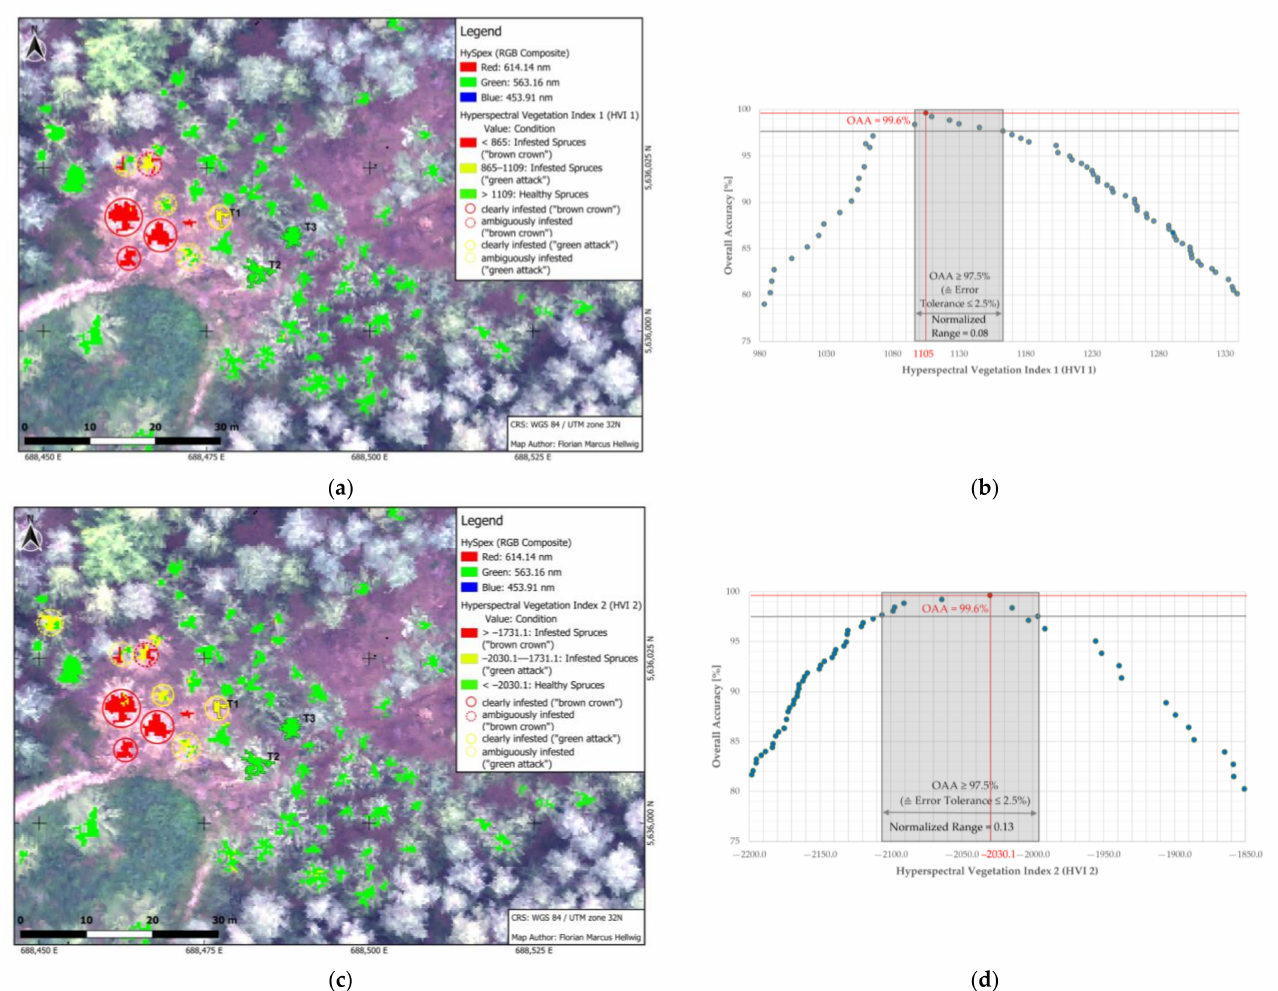
Figure 13. State of the spruces in the first study area using hyperspectral vegetation index 1 (HVI 1) ( a ) and HVI 2 ( c ). A total of eight spruces were found to be (ambiguously) infested by HVI 1, none of which did not belong to the removed spruces ( a ), whereas a total of nine spruces were found to be (ambiguously) infested by HVI 2, of which one spruce did not belong to the removed spruces ( c ). Normalized variations of the overall accuracy (OAA) for all central pixels of T1–3 using hyperspectral vegetation index 1 (HVI 1) ( b ) and HVI 2 ( d ). A small range of values from 1097–1163 still allowed a very high OAA of ≥ 97.5% or error tolerance ≤ 2.5% (normalized range = 0.08) for HVI 1 ( b ), while for HVI 2 the range of values is larger ( − 2106.3–1996.4 and 0.13, respectively) ( d ). The threshold value 1105 was chosen for the classification (OAA = 99.6%) ( b ) and − 2030.1, respectively (OAA = 99.6%) ( d